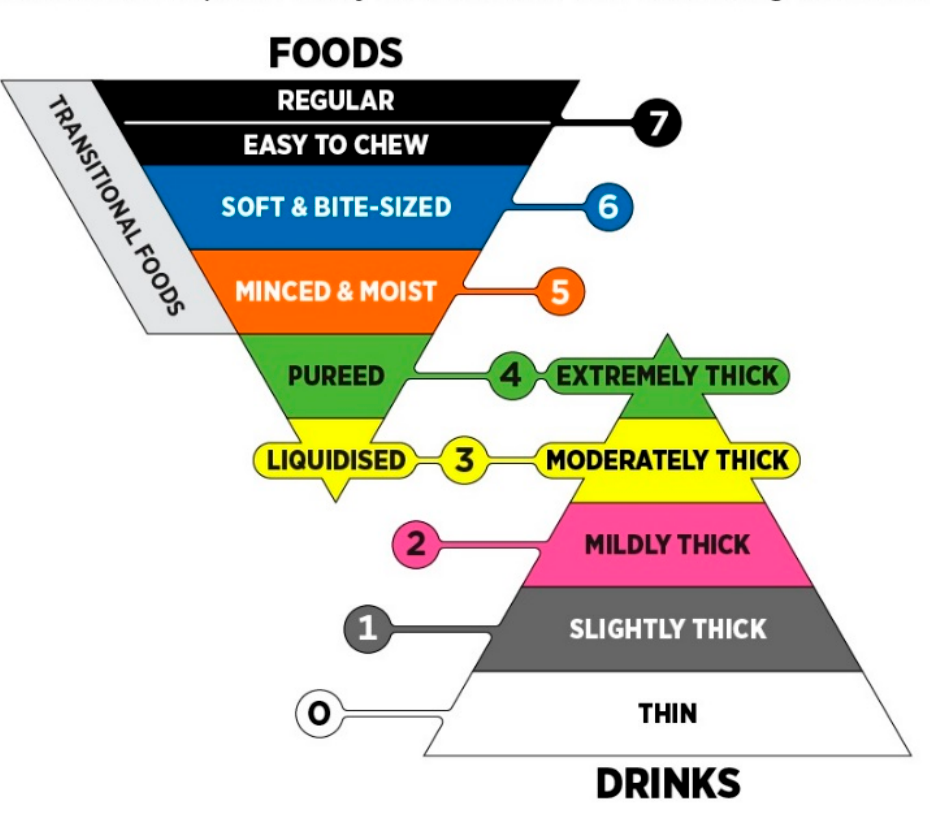
Figure 3. The IDDSI framework (Reprinted from IDDSI, 2019 [22]. Permitted by Creative Commons Attribution-Non Commercial 4.0 International License https://creativecommons.org/licenses/by/4.0/, accessed on 6 June 2022)